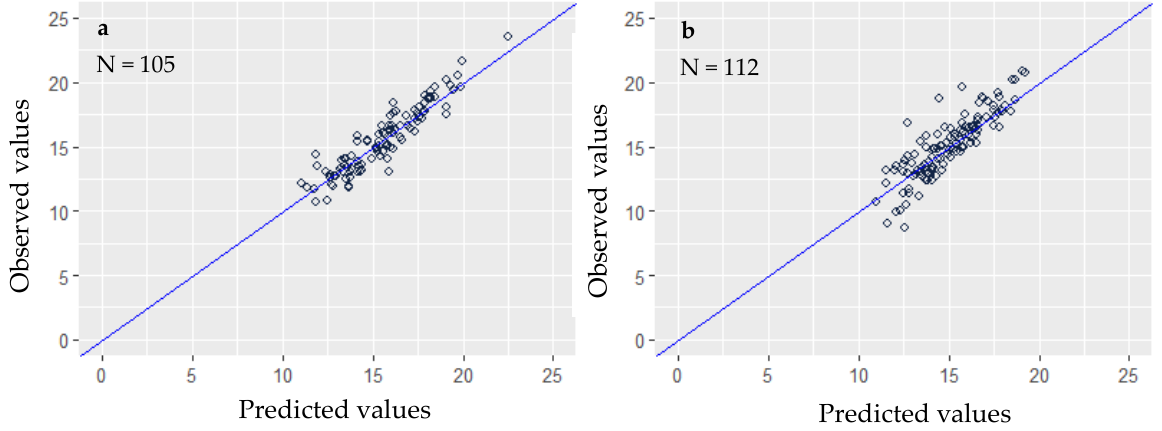
Figure 7. Observed total tree height plotted against predicted values with a line of unity for ( a ) white spruce and ( b ) balsam fir.